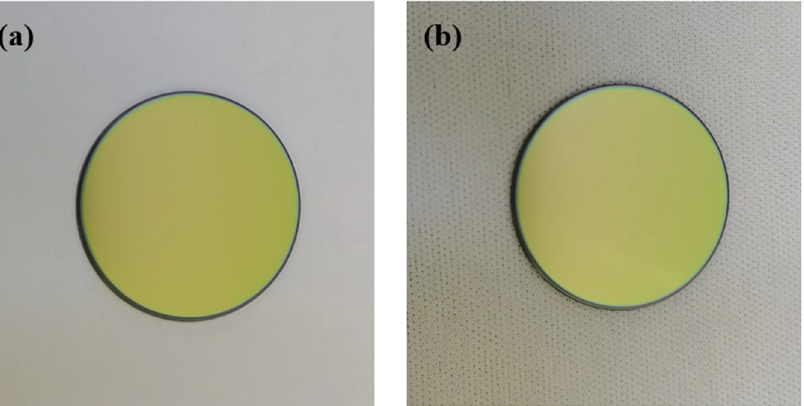
Figure 10. Typical damage morphologies of the dichroic beamsplitters at 1064 nm ( a ) and 532 nm ( b ) laser irradiation. The area inside the red dashed line marks the damage black spot.